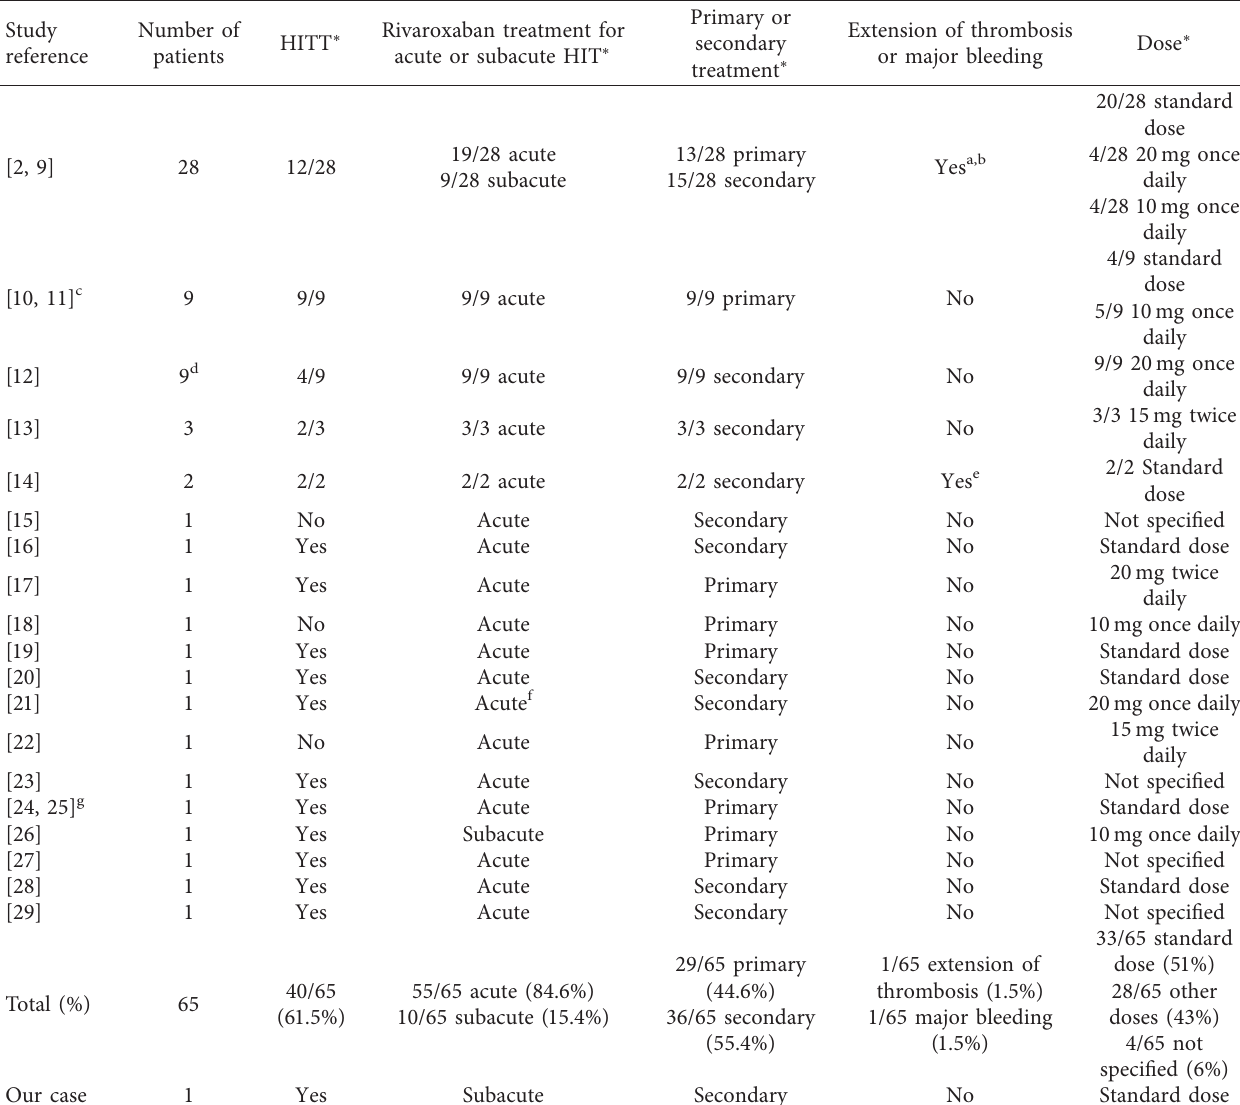
Table 1: Cohort studies and case reports of rivaroxaban for the treatment of